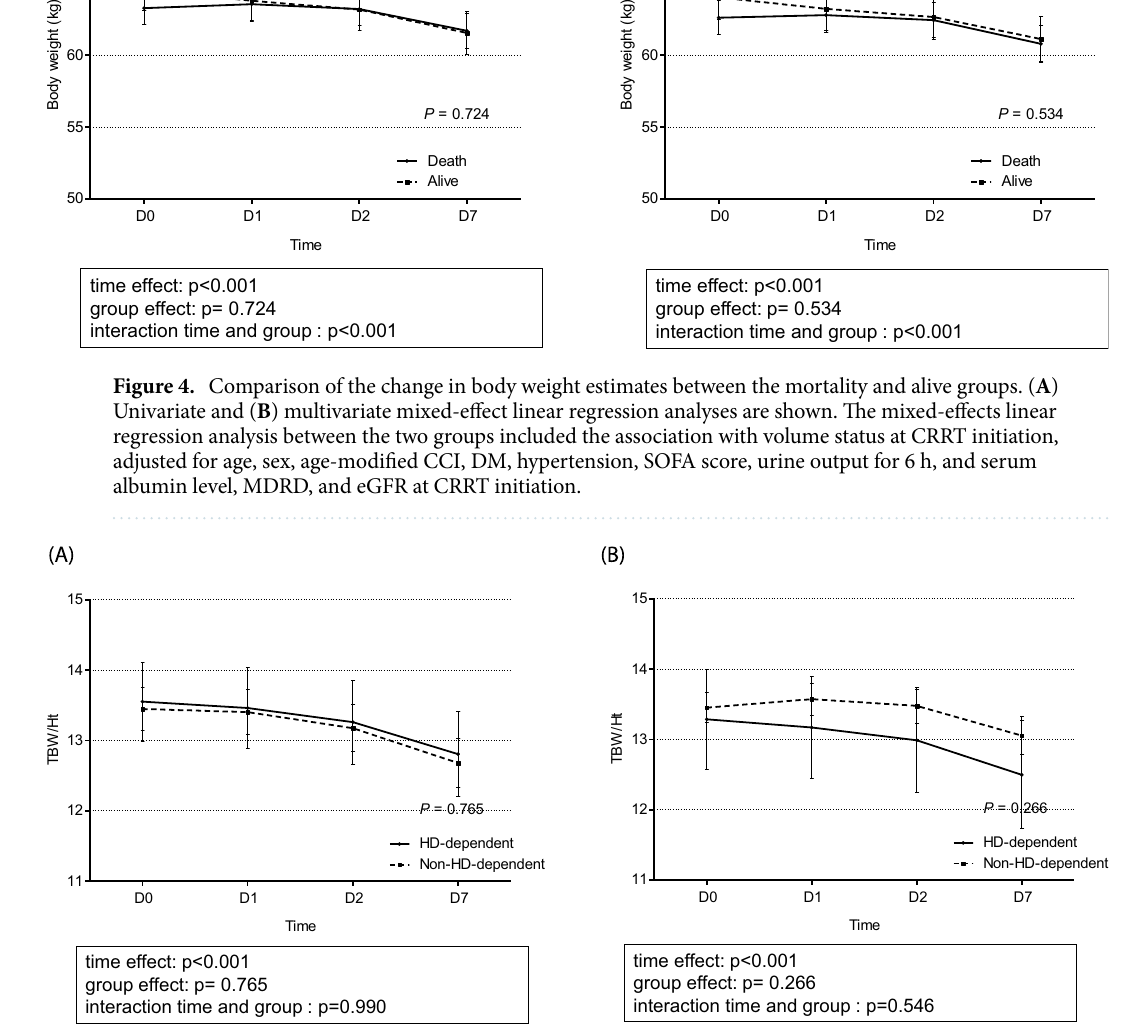
Figure 5. Comparison of the change in TBW/H 2 estimates between the dialysis dependent group and non- dialysis dependent groups. ( A ) Univariate and ( B ) multivariate mixed-effect linear regression analyses are shown. The mixed-effects linear regression analysis between the two groups included the association with volume status at CRRT initiation, adjusted for age, sex, age-modified CCI, DM, hypertension, SOFA score, urine output for 6 h, and serum albumin level, MDRD, and eGFR at CRRT